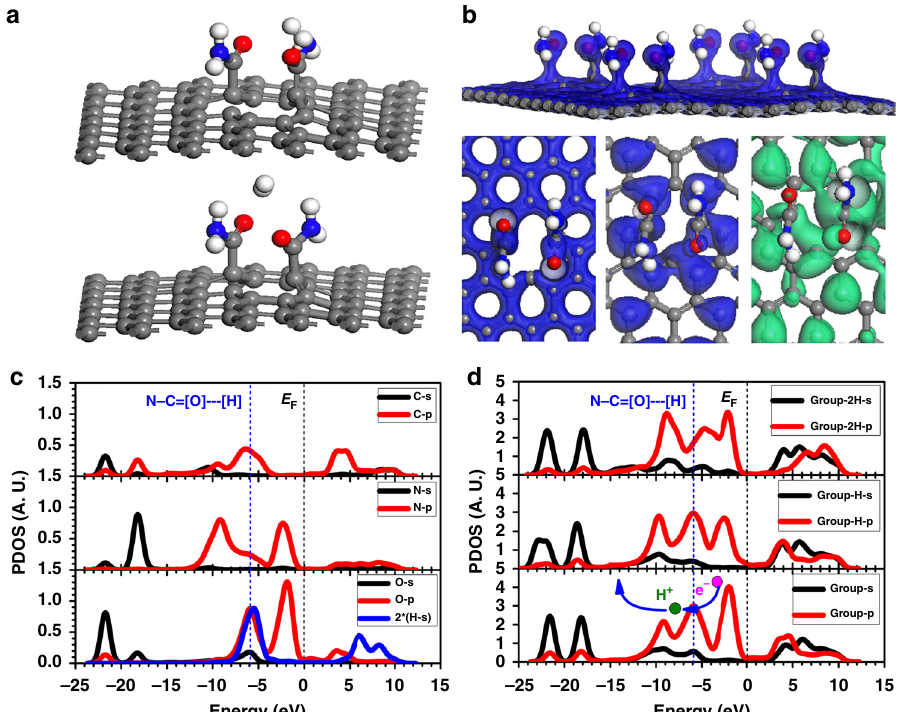
Fig. 1 Electronic structures and projected density of states for HER process. a Geometry optimized paired groups (CONH 2 ) with mono-H adsorption and H 2 stabilized between them. b The orbital charge densities for ef fi cient s-p band overlapping for proton – electron exchange. c PDOSs comparison of the group. d PDOS variations of the paired groups during the HER process